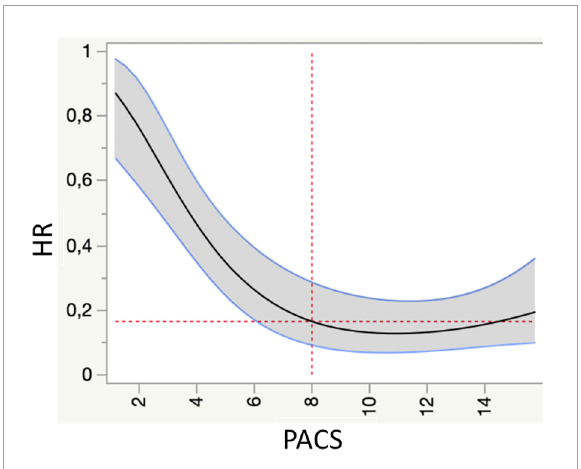
FIGURE1 Spline knotted survival curve to assess the value of peak atrial contraction strain (PACS) as a predictor of cardiovascular mortality (primary endpoint). HR, hazard